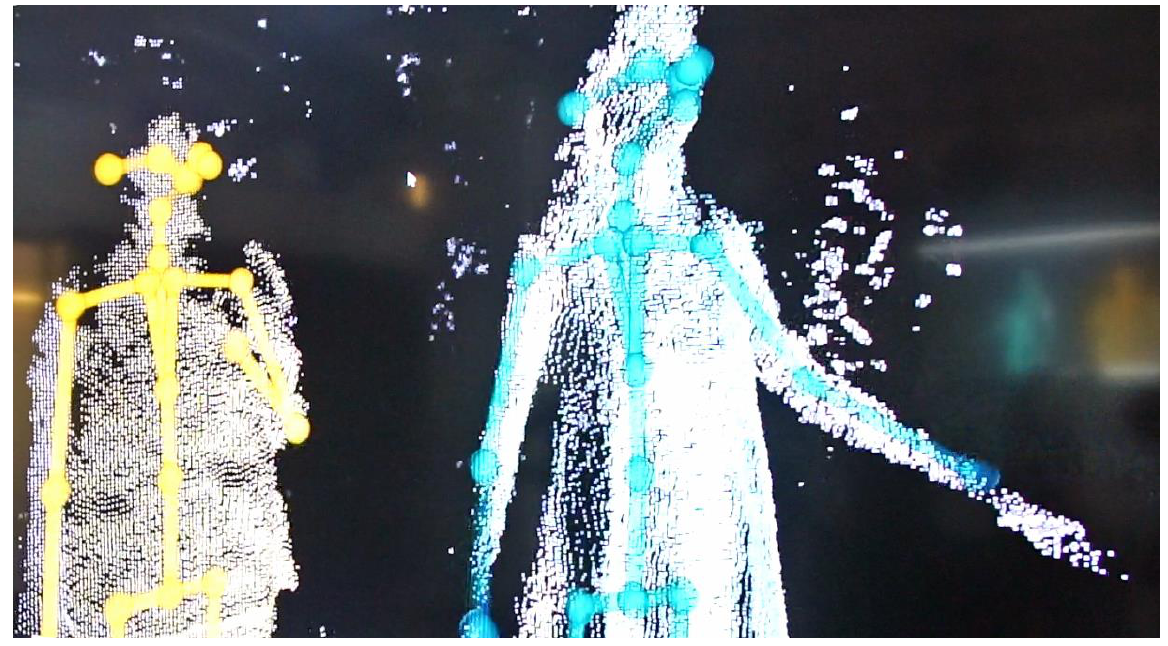
Figure 3. Pedestrian identification, motion detection, and pose inference using RGB + D depth map-